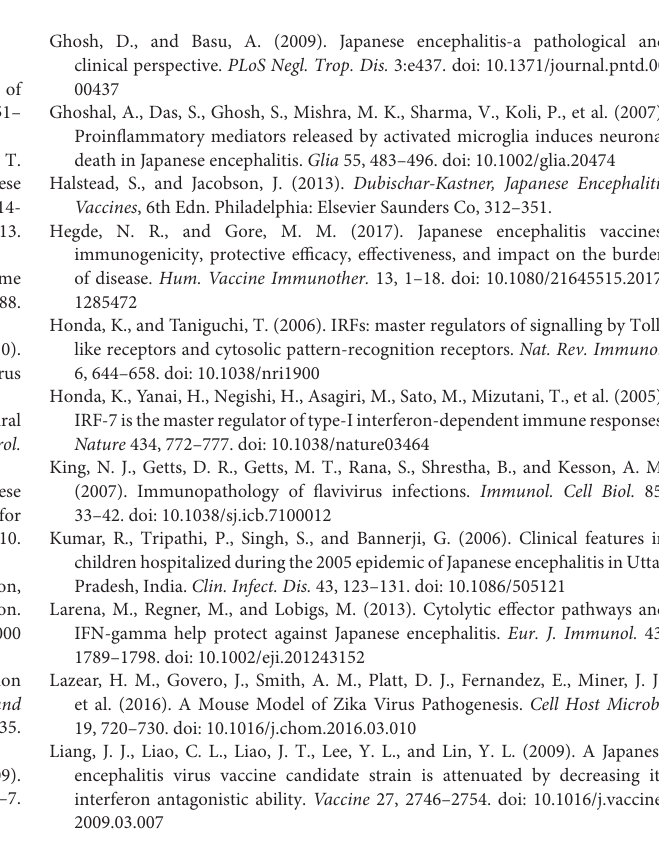
Supplementary Figure 1 | Comparative photomicrograph of the lung, kidney, and brain tissue sections from SA14-14-2 strain infected- and uninfected-WT and IFNAR − / − mice. H&E; 20 × and 200 × . Representative pictures of tissues were collected at 4 dpi and stained with hematoxylin and eosin. No significant pathological changes were observed in lung (A) , kidney (B) , and brain (C) collected from corresponding infected and uninfected